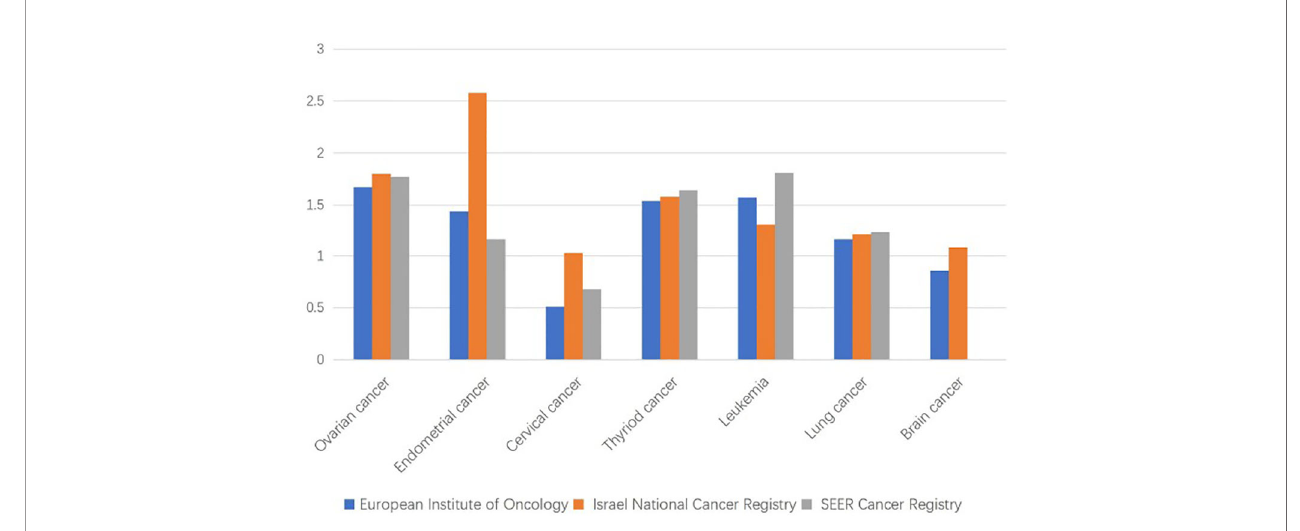
FIGURE 1 | Standardized incidence ratios for common multiple primary cancer sites associated with breast cancer